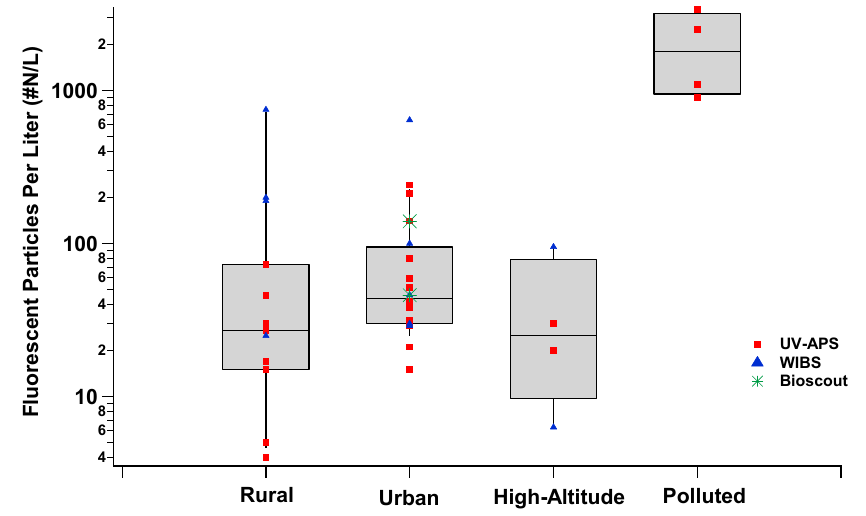
Figure 3. Mean number of fluorescent particles per liter counted for selected ambient environments. (Squares indicate values sampled using the UV-APS, triangles for WIBS and stars for the BioScout). The grey box plot and whiskers indicate the 10th, 25th, 50th, 75th, and 90th percentiles for the data.